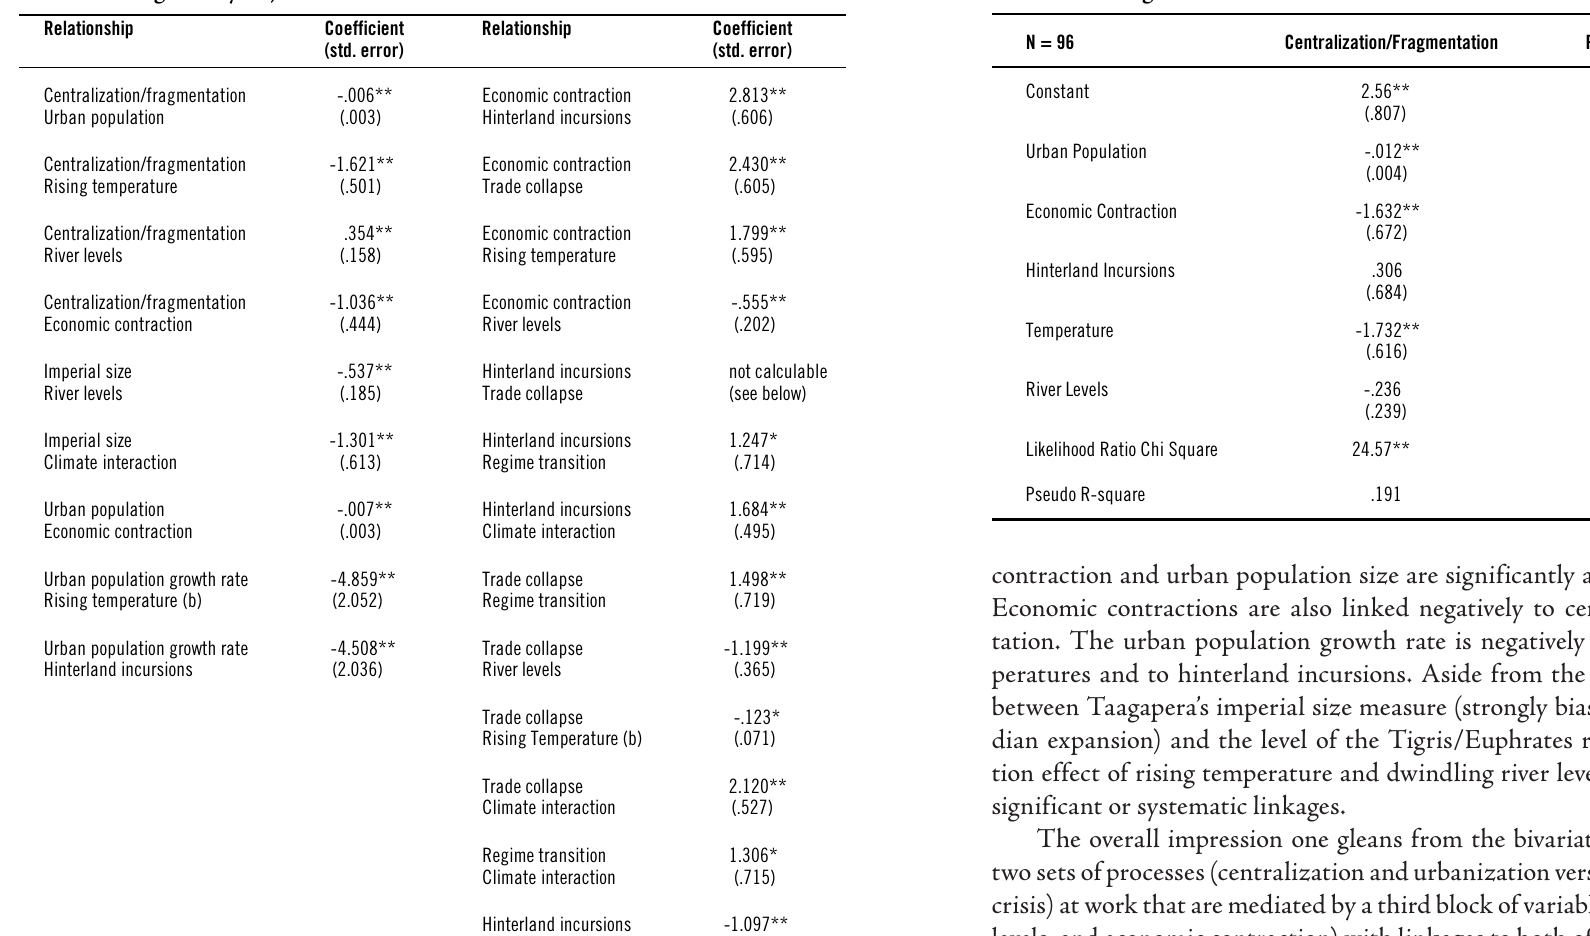
Table 3 – Statistically Significant Mesopotamian Relationships (bivariate Table 4 – Two Multivariate Logit Analyses of Mesopotamian